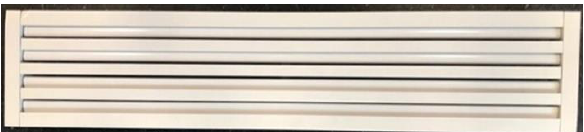
Fig. 4 . SLN diffuser photo.